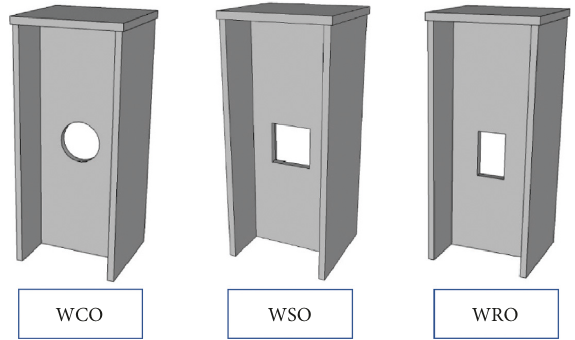
Figure 19: The steel beam and opening configuration.